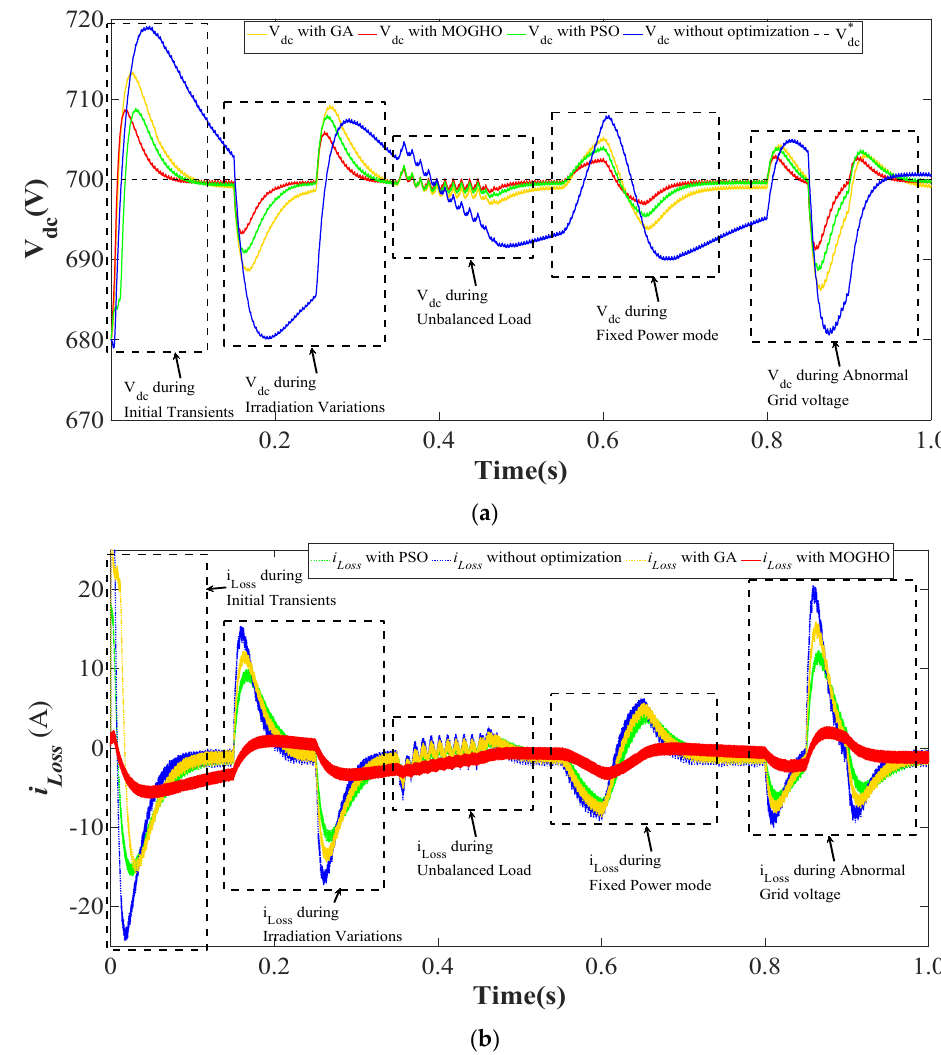
Figure 9. ( a , b ) Optimized V dc analysis during dynamic conditions. ( b ) Optimized i Loss current analysis during dynamic conditions system. Table 2. Optimized design variables ( 𝑘 𝑝 , 𝑘 𝑖 and 𝛿 ). Table 3. Comparative performance of DC